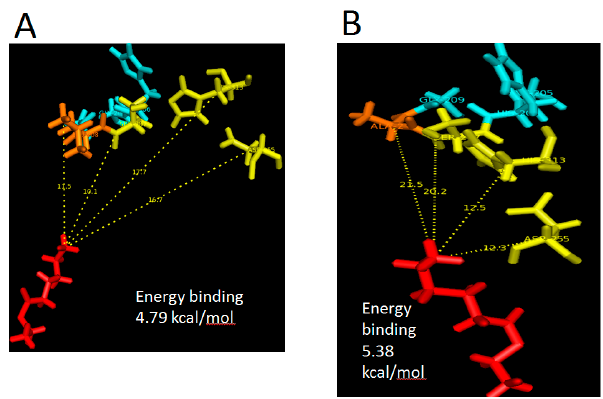
Figure 8. Docking of wild-type AMS8 ( A ) and mutant L208A ( B ) with ethyl hexanoate (C 8 H 16 O 2 ). Asp-255 and His-313 were seen moving closer to substrate and the nucleophilic elbow ( B ). Ethyl hexanoate was identified in stick colored in red, all catalytic residues in yellow, mutated or non-mutated Leu-208 in orange (with re-orientated side chain) and surrounding residues of GXSXG motifs (Gly-205, His-206, Gly-209) were identified in turquoise.